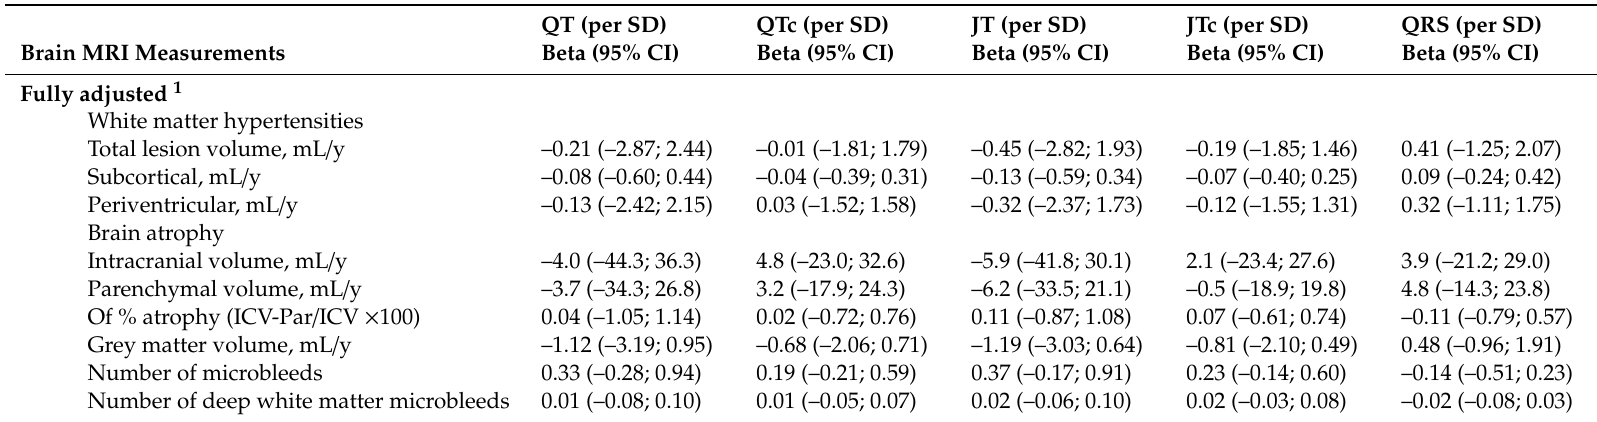
Table 4. Cross-sectional associations between measures of ventricular de- and repolarization and brain MRI measurements at